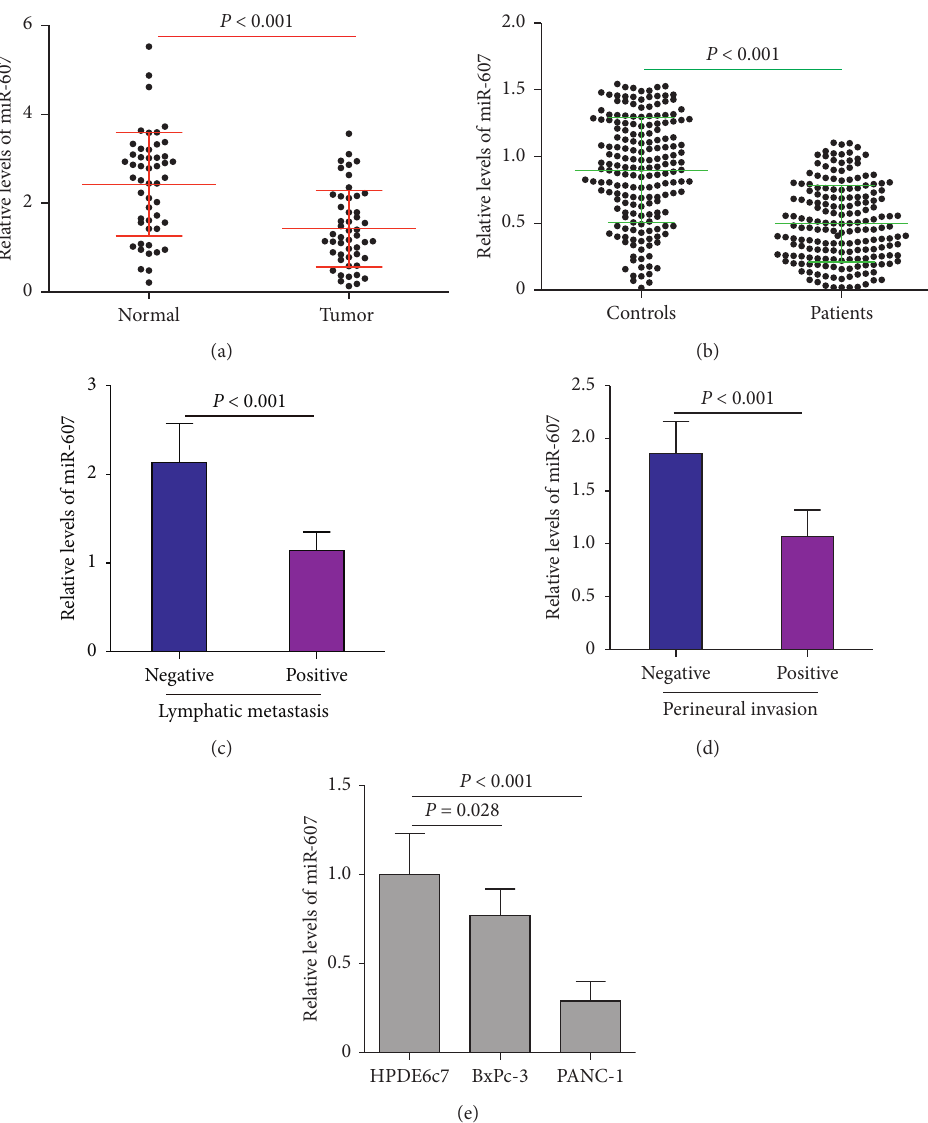
Figure 1: The expression levels of miR-607 in patients with PDAC. (a) qRT-PCR analysis of miR-607 expression levels (normalized to U6) in 50 pairs of PDAC tumor tissues and adjacent normal tissues. (b) Analysis of serum miR-607 levels in 184 pairs of PDAC patients and healthy controls. (c) Comparison of the relative expression levels of miR-607 in PDAC tumor tissues with positive lymphatic metastasis and other PDAC tumor tissues with negative lymphatic metastasis. (d) The expression levels of miR-607 were analyzed in PDAC tumor tissues with positive perineural invasion and other PDAC tumor tissues with negative perineural invasion. (e) Levels of miR-607 in the BxPc-3 and PANC-1 cells are lower than those in the HPDE6c7 cells. qRT-PCR: quantitative real-time polymerase chain reaction, PDAC: pancreatic ductal adenocarcinoma. Data are represented as the mean ± SD from three independent